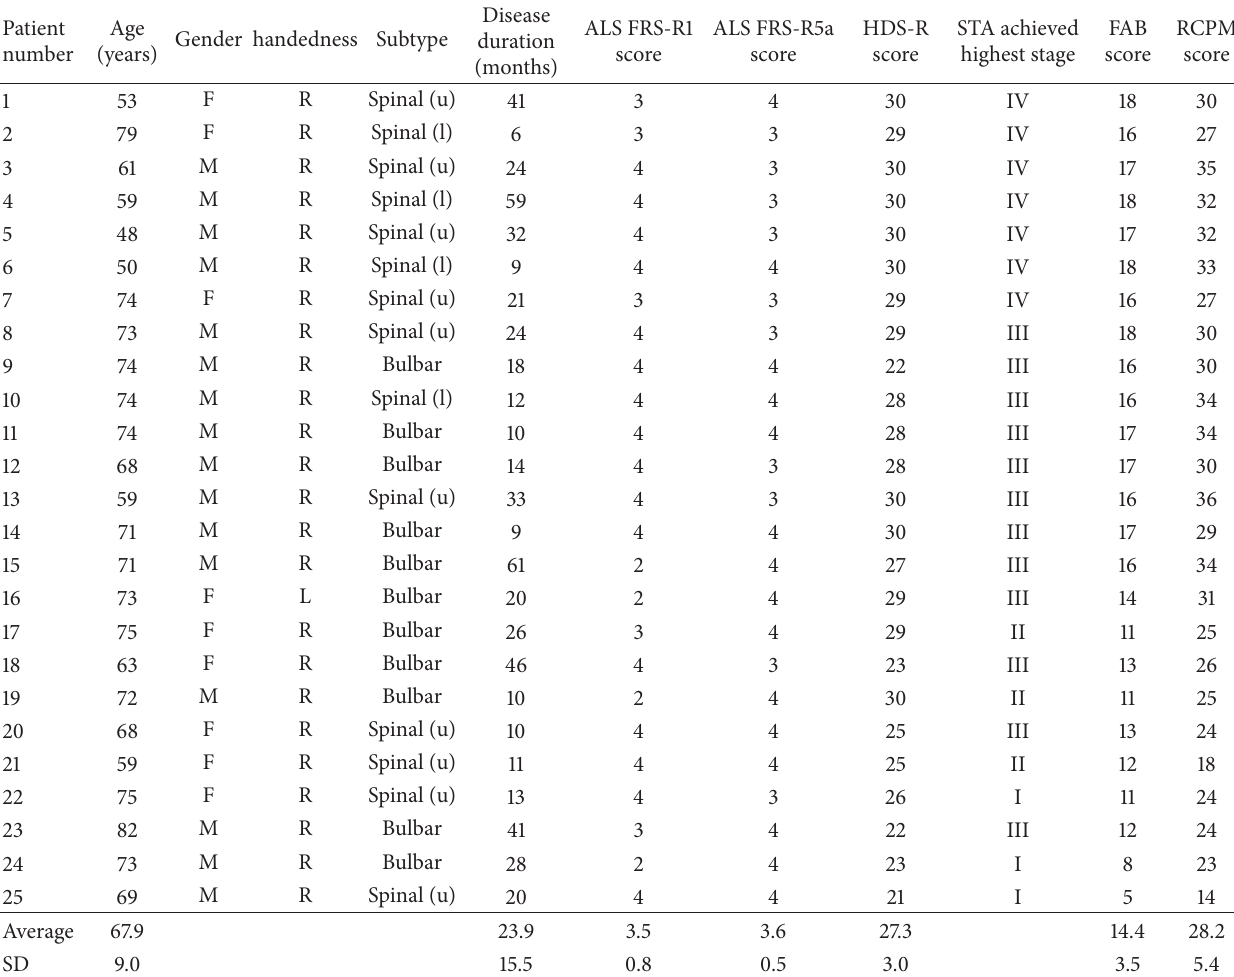
Table 2: Patient characteristics and the results of neuropsychological